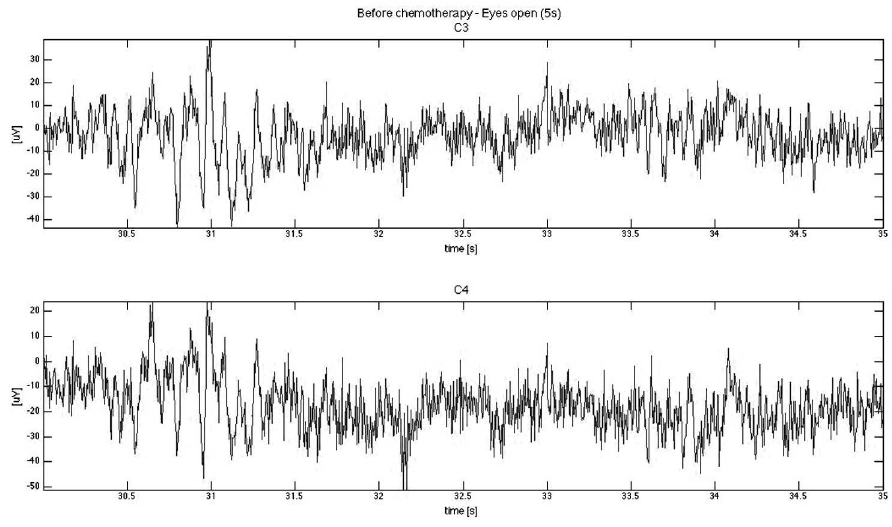
Figure 2. EEG data, eyes open, raw signal (1–70 Hz, Hardware-based processing), C3 (top) and C4 (bottom) – before chemotherapy onds of data). The data was recorded at closed eyes before chemotherapy. Numerous artifacts are visible in the EEG spectrogram. The EEG recordings show numerous artifacts such as eye blinking and eyes movement (Figure